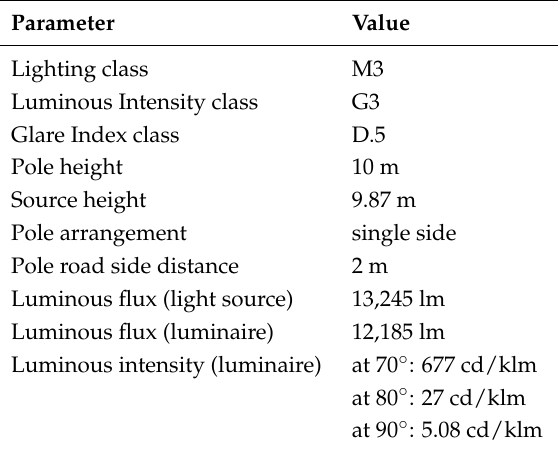
Table 4. Input parameters for lighting design for Case A and Case